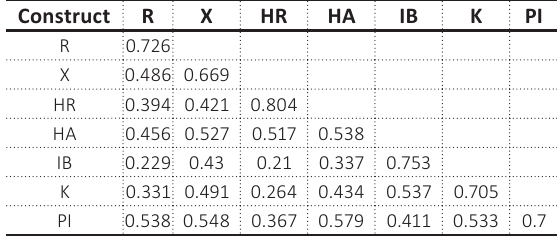
Source: Own calculations.